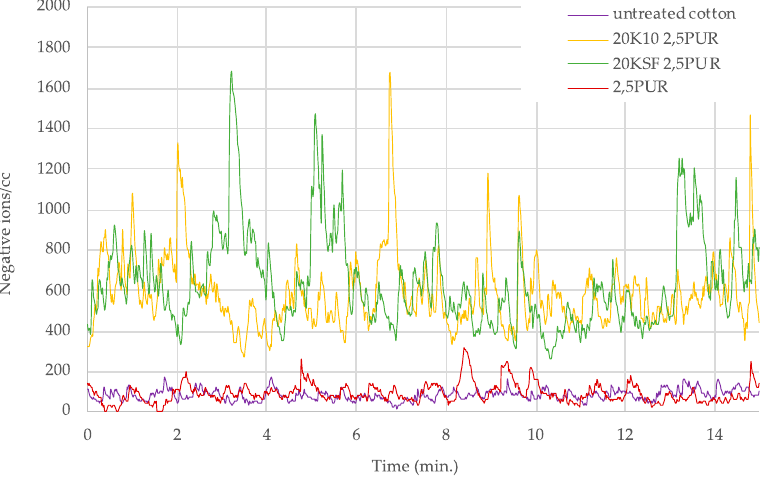
Figure 6. Negative ions/cc in 15 min released by treated samples with 2.5 g/L of polyurethane binder.